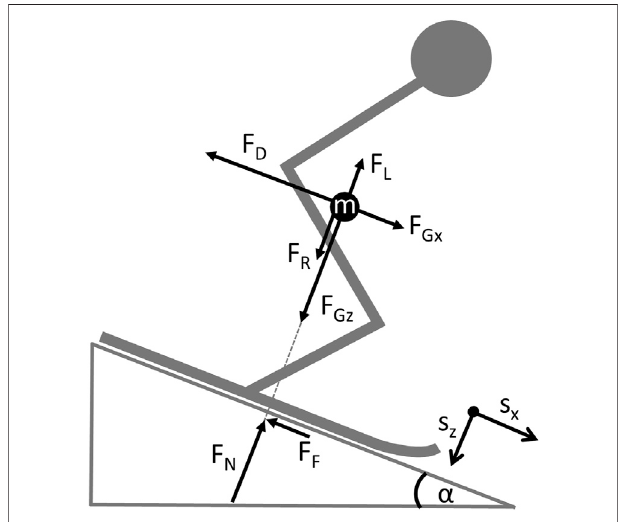
FIGURE3| Freebodydiagramvisualizingtheforcesactingonanathlete during a test run. The curvature of the terrain is not visualized.